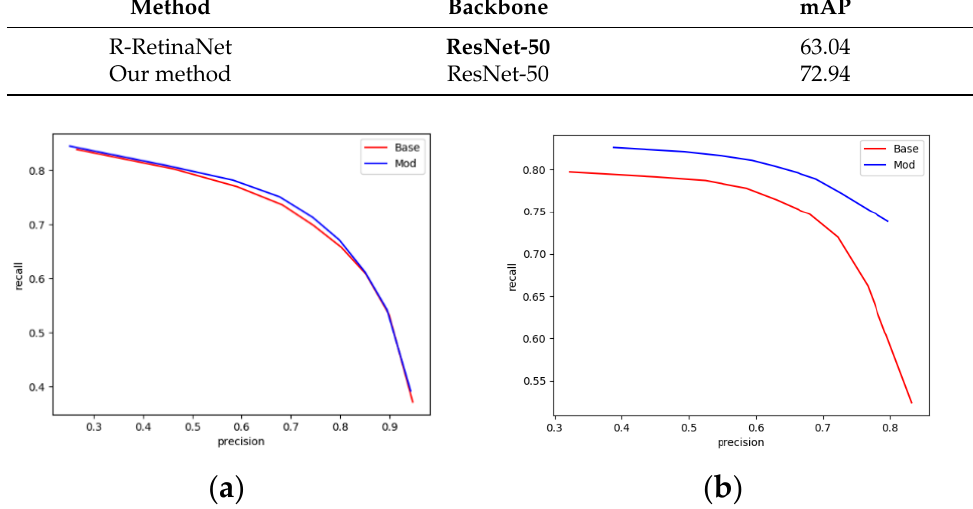
Figure 5. Comparison of accuracy recall curve between baseline method and this method. ( a ) DOTA. ( b ) HRSC2016.